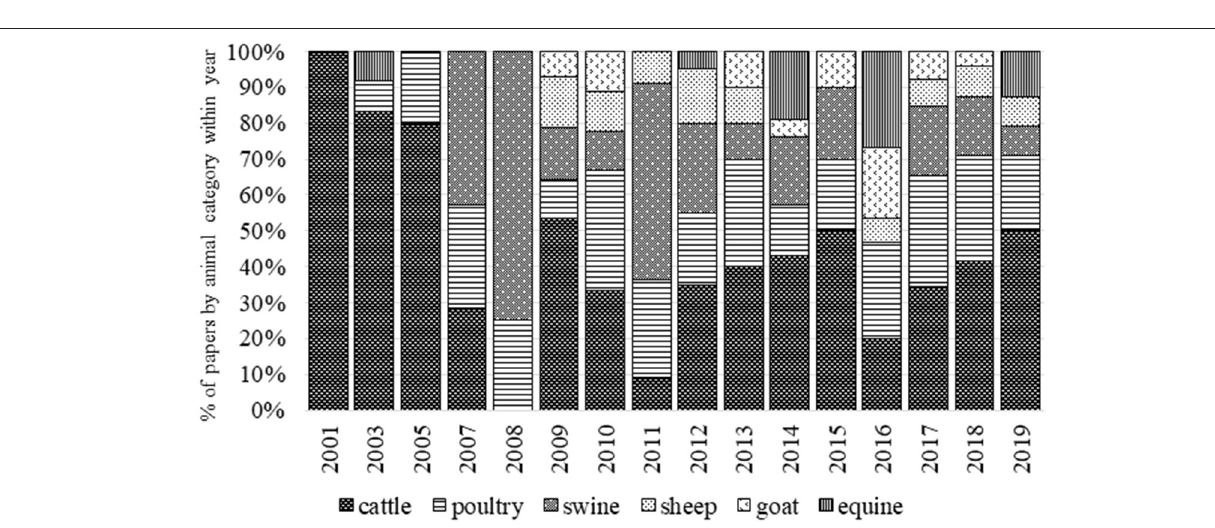
FIGURE 4 | Frequency distribution of papers including a general animal-based measures codified term according to the animal species within the year of